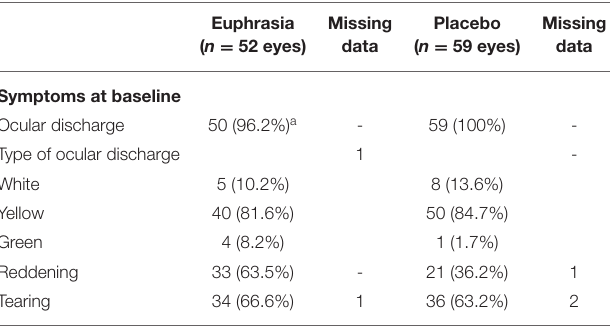
TABLE 3 | Ocular health at baseline according to treatment arm ( n = 84 neonates, 111 affected eyes).